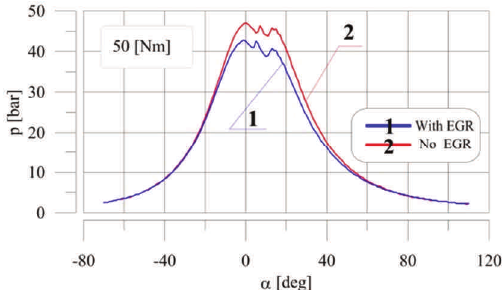
Fig. 4. Influence of the engine crank angle on the pressure inside engine cylinder for engine operating with/without EGR at torque 50 Nm